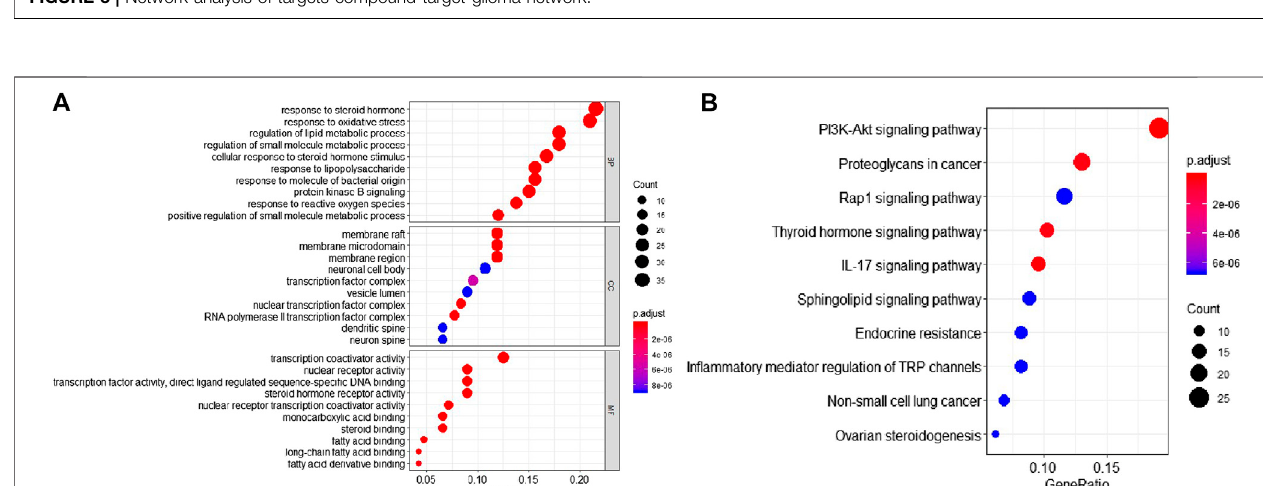
FIGURE 3 | Network analysis of targets compound-target-glioma